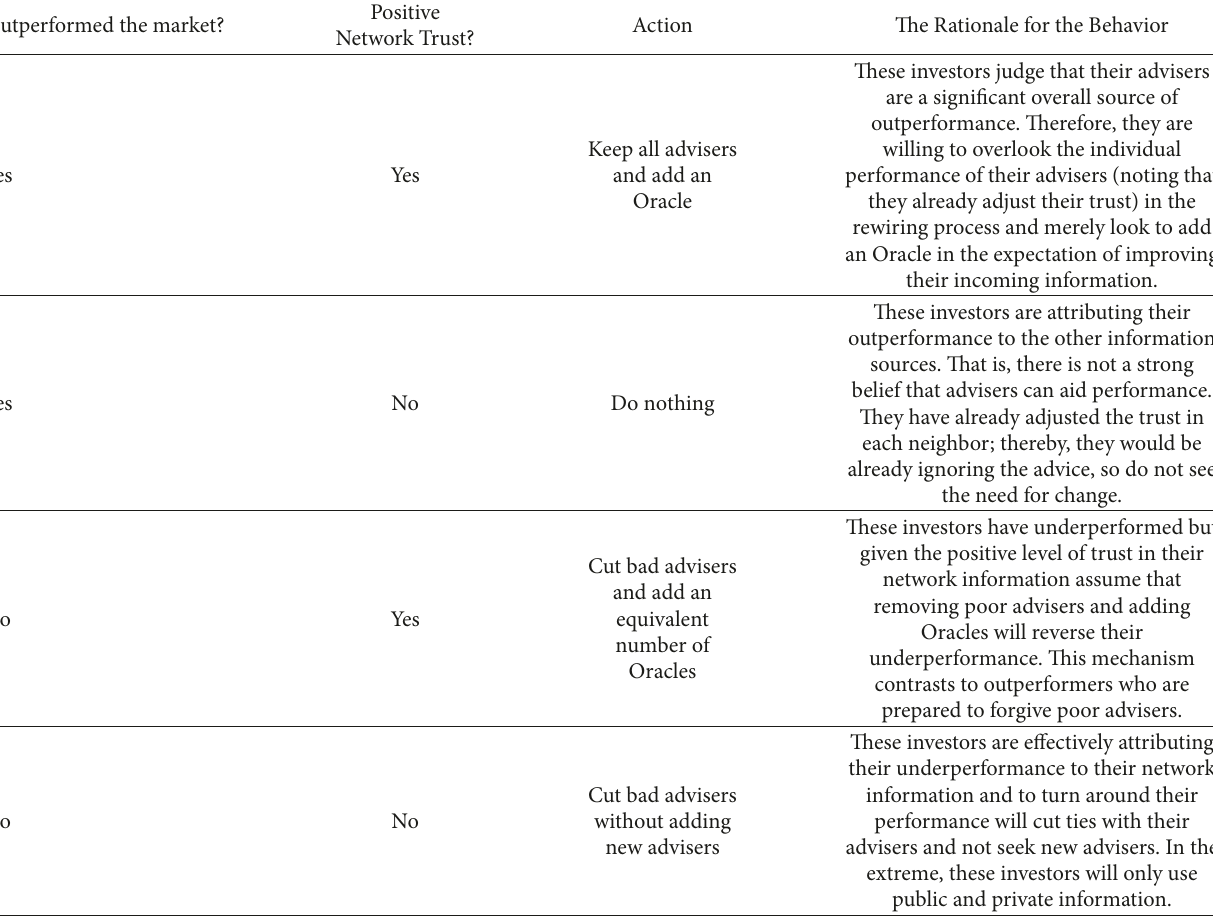
Table 2: Investor network behavior